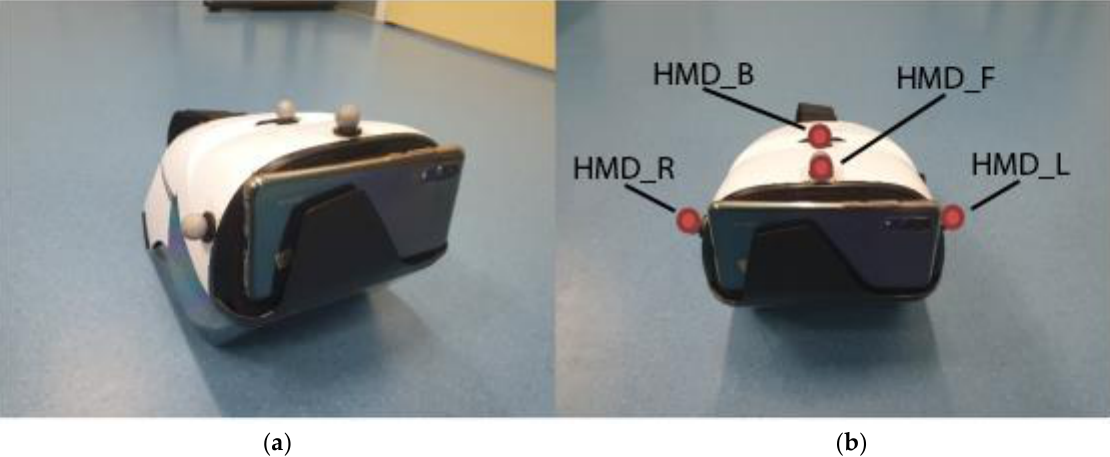
Figure 2. Marker Placement on the Head Mounted Display consisting of a headset and a smartphone. ( a ) Shows marker placed on the head mounted display. ( b ) The four markers are highlighted red and labelled as in the used marker model.